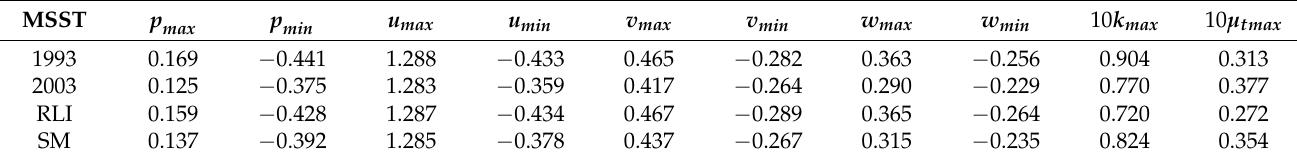
Table 4. Extreme flow parameter values and the turbulence characteristics for the standard and modified SST models.